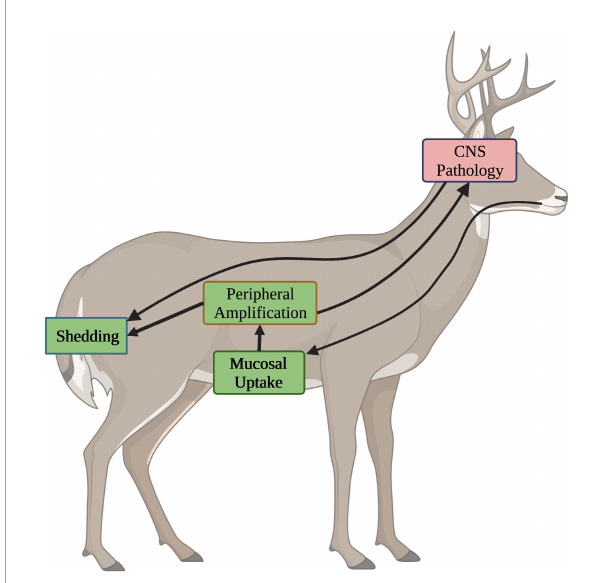
FIGURE 2 Stages of CWD and Opportunities for